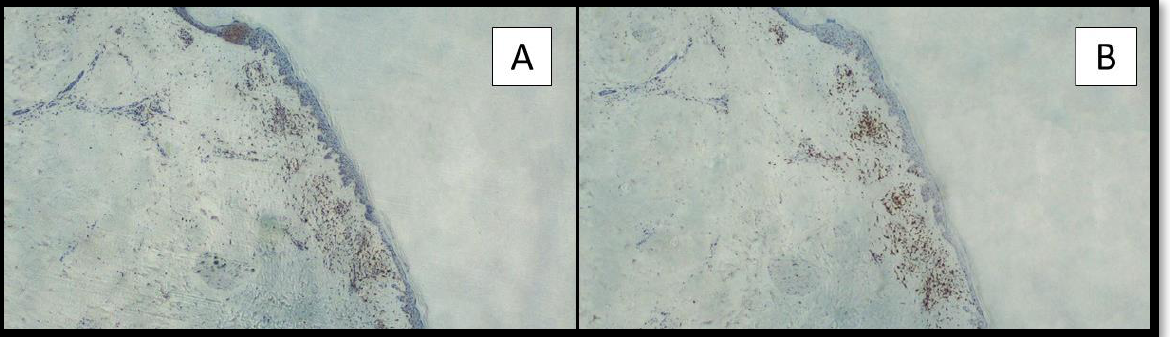
Figure 5. Detail at greater magnification that shows the presence of erythrocytes between the collagen fibers of the superficial dermis (Hematoxylin-Eosin; Original Magnification 20 × ).